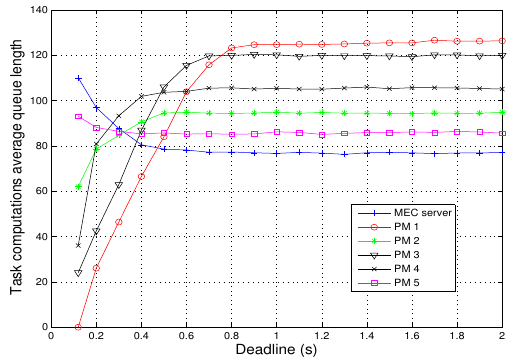
Figure 6. Task computation average queue length vs.